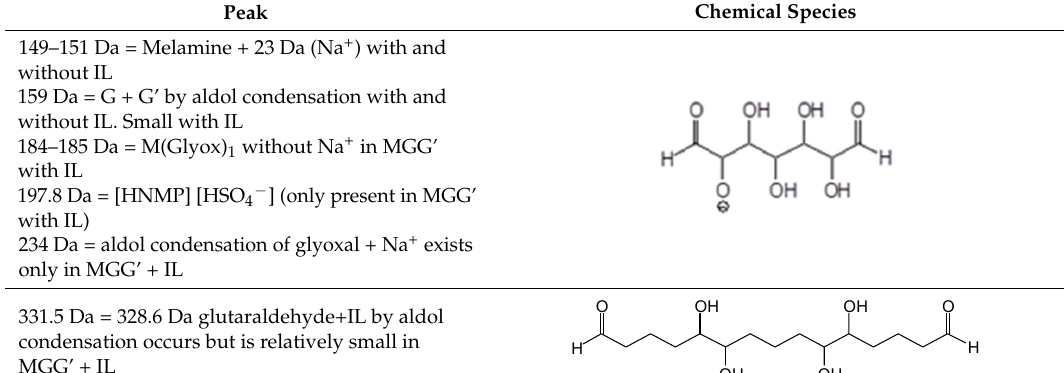
Table 6. Oligomers formed by the reaction of MGG’ with and without